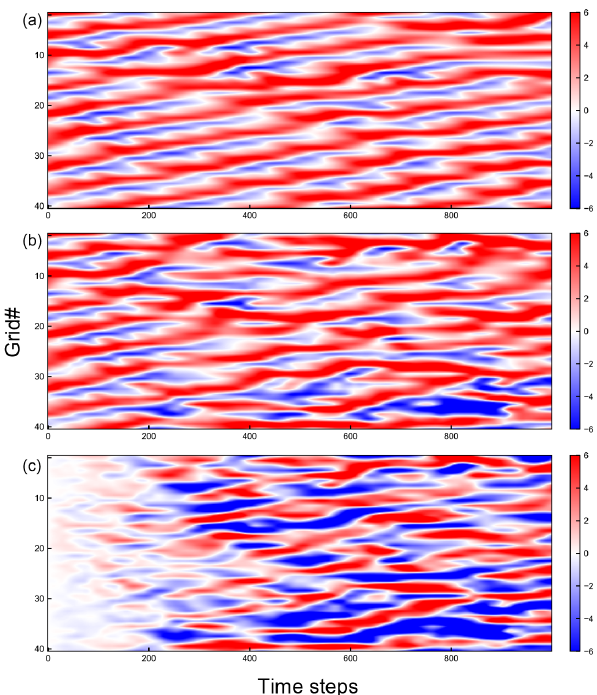
Figure 4. The Hovmöller diagram of (a) Nature Run, (b) a predic- tion of RC-Obs, and (c) difference between (a) and (b) . Horizontal axis shows the time steps and vertical axis shows the nodal number. Value at each time step and node is represented by the color.